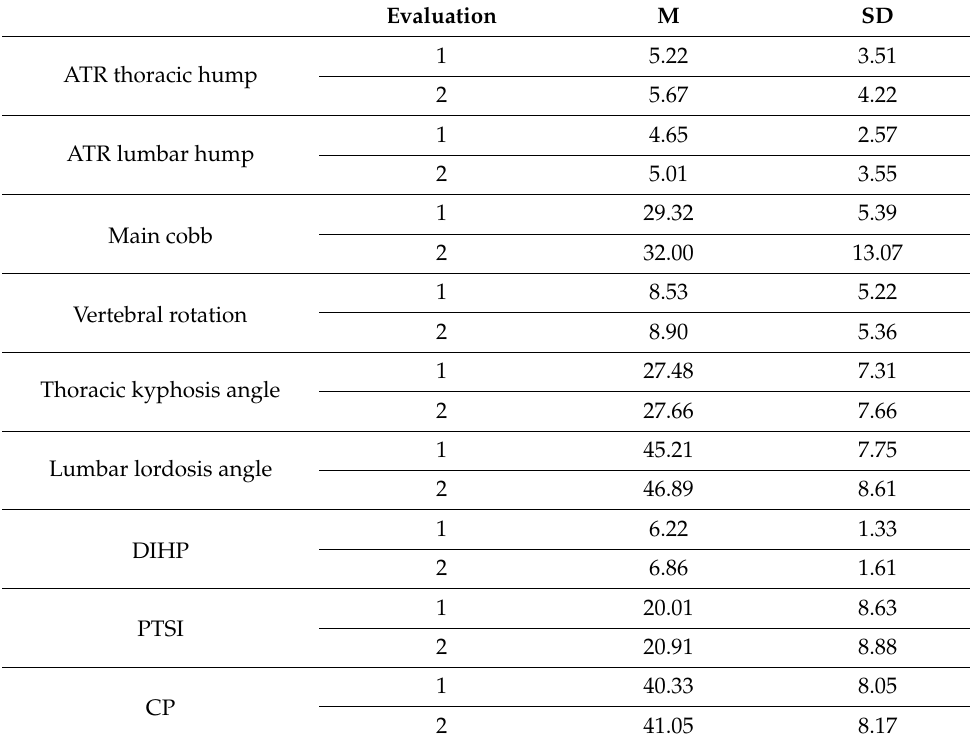
Table 1. Descriptive statistics (initial assessment 1-final assessment 2) for topographic and radio- graphic variables.